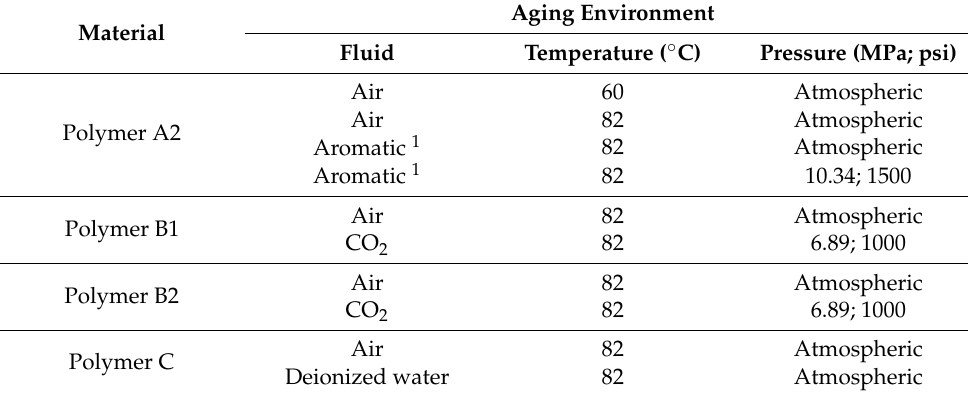
Table 1. Materials tested for aging effects in specified environments. Aging Environment Material Fluid Temperature ( ◦ C) Pressure (MPa; psi) Air Polymer A2